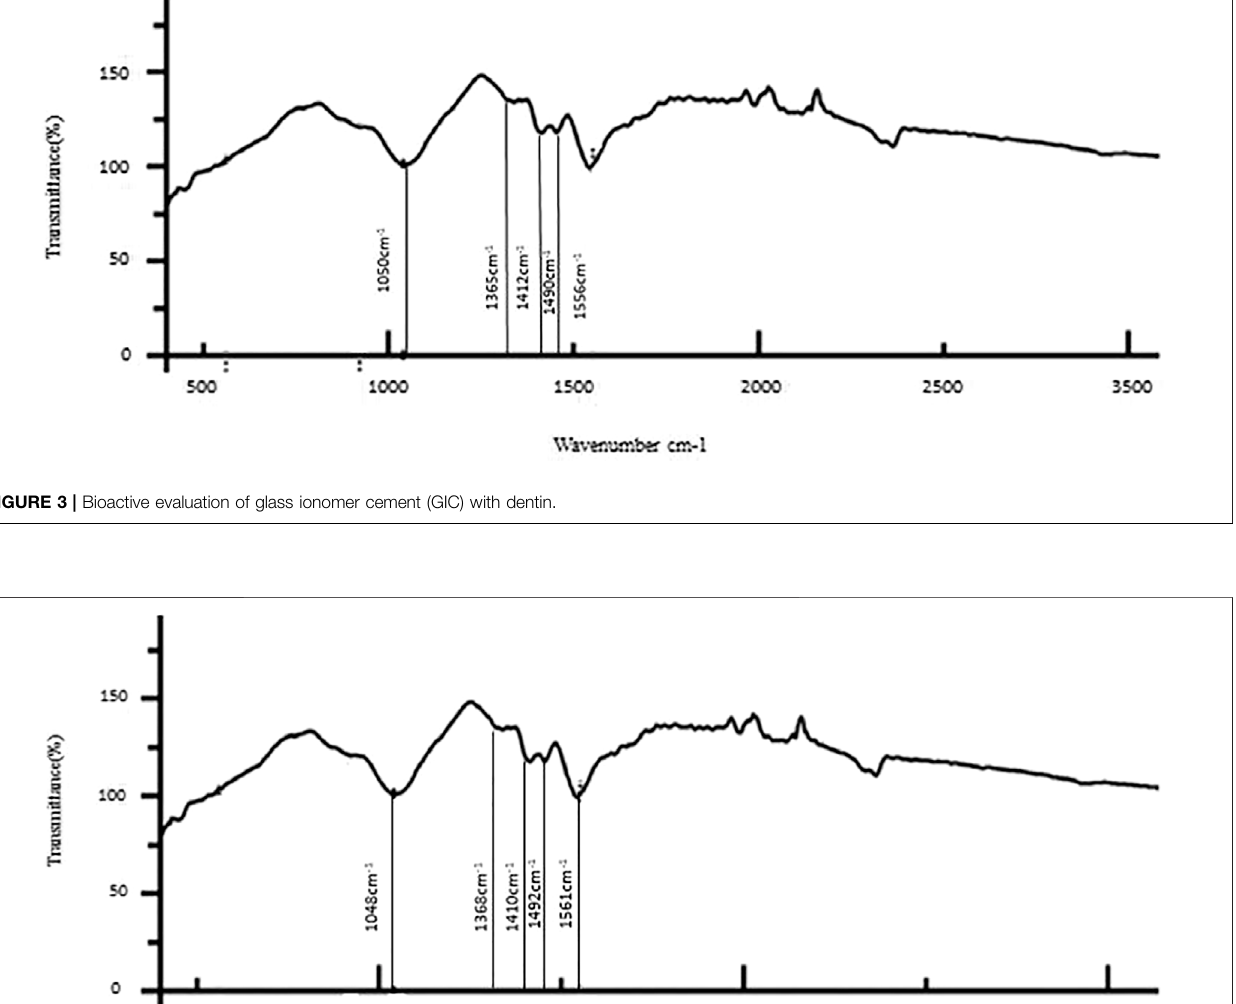
Frontiers in Bioengineering and Biotechnology |